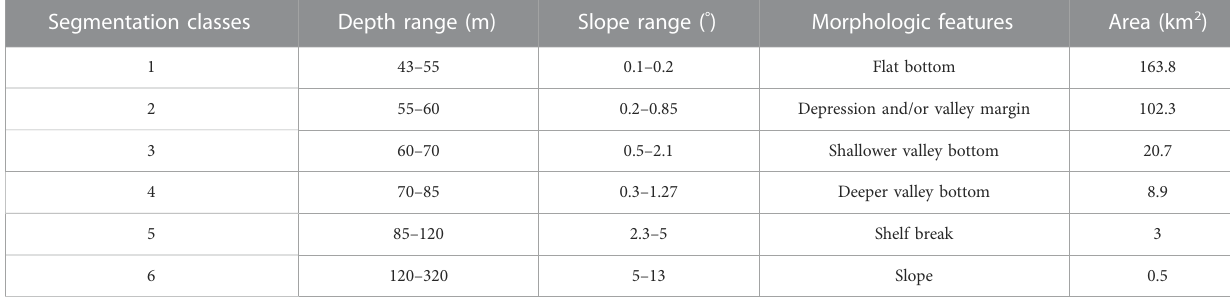
TABLE 2 Segmentation classes (geomorphic classes) and their geomorphometric and geomorphological features. Segmentation